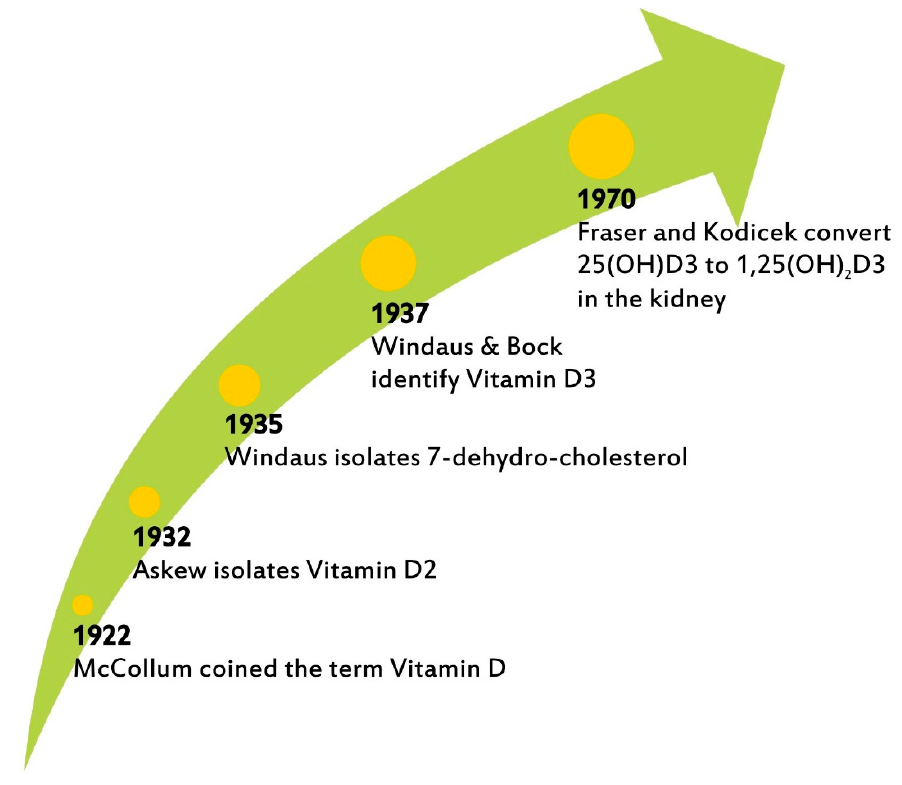
Figure 1. The chronography of VitD3 discovery.